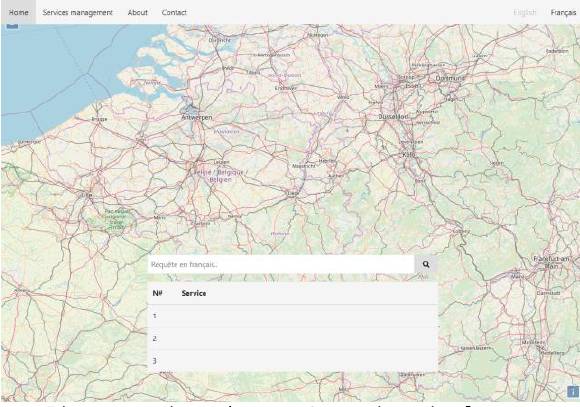
Figure 1. Project web page - Semantic retrieval